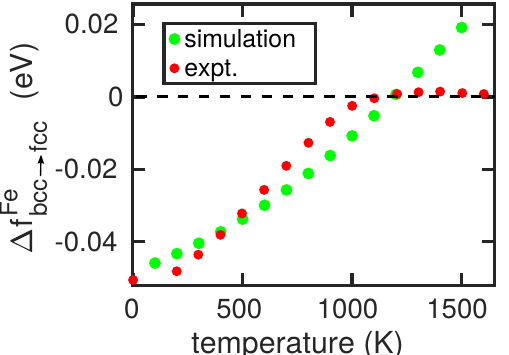
Figure 2. Free-energy difference of the bcc and fcc phase of Fe in the modified Johnson potential presented in Appendix A as a function of temperature. Experimental data from